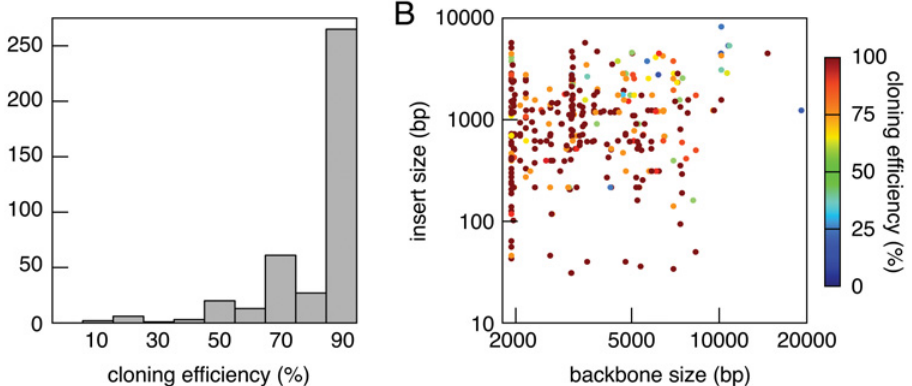
Fig 2. Efficiency of the MXS-chaining approach. (A) Cloning efficiency of the MXS-chaining approach measured as the fraction of positive recombinant plasmids resulting from MXS-chaining ligation reactions. (B) Dependence of the cloning efficiency on sizes of MX-digested vectors and MS-digested inserts. Data from 400 different MXS-chaining ligation reactions is